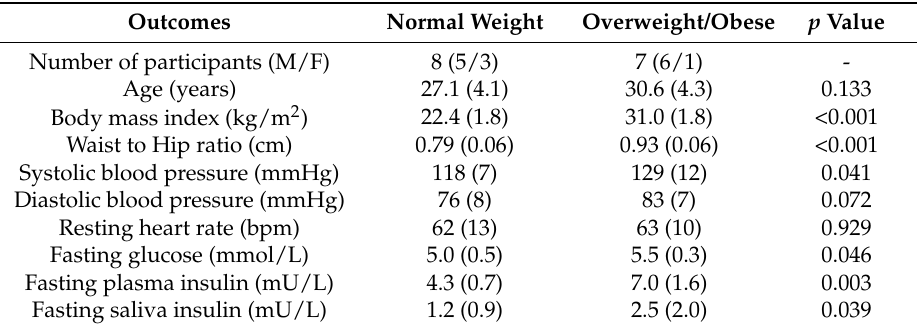
Table 1. Baseline participants’